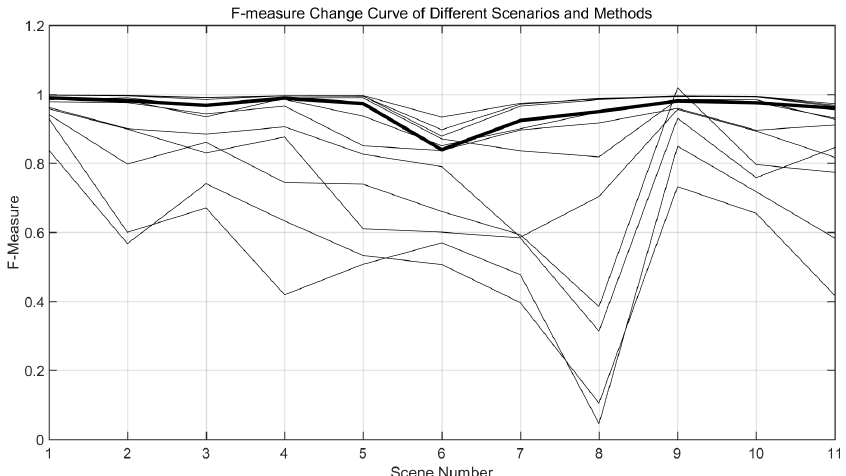
Figure 6. The change curve of the comprehensive index F relative to each category of the data set: the bold broken line segment is the result corresponding to the method in this paper, and is one of the several broken line segments closest to the straight line at